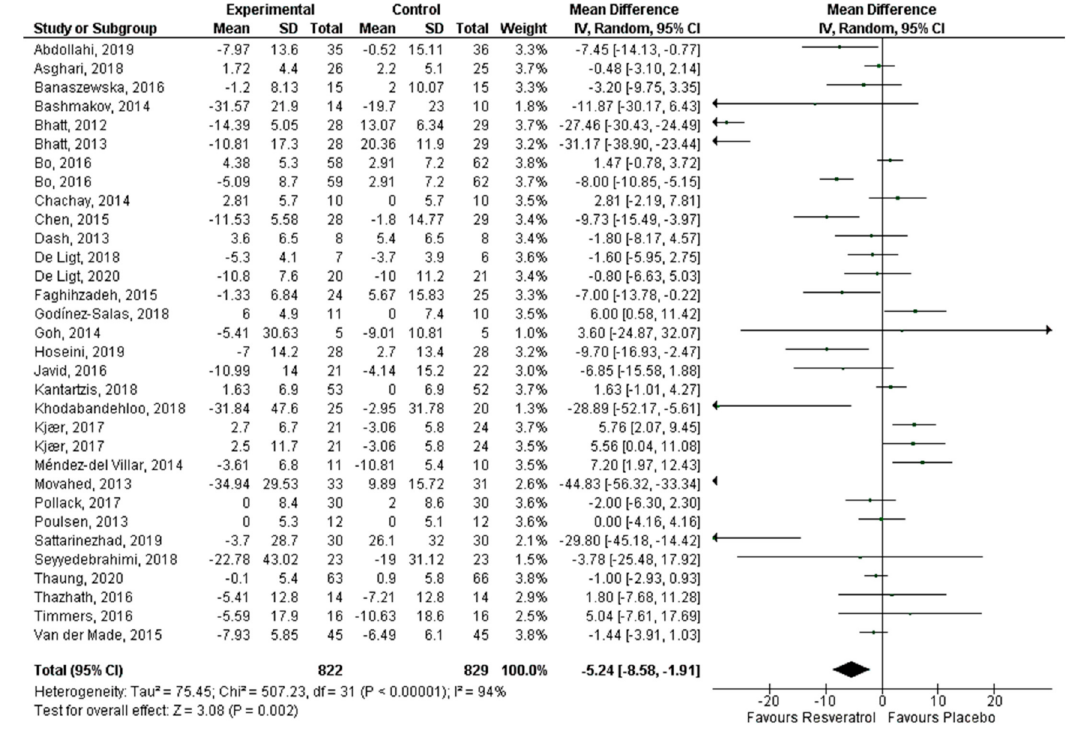
Figure 3. Effect of resveratrol on glucose levels.